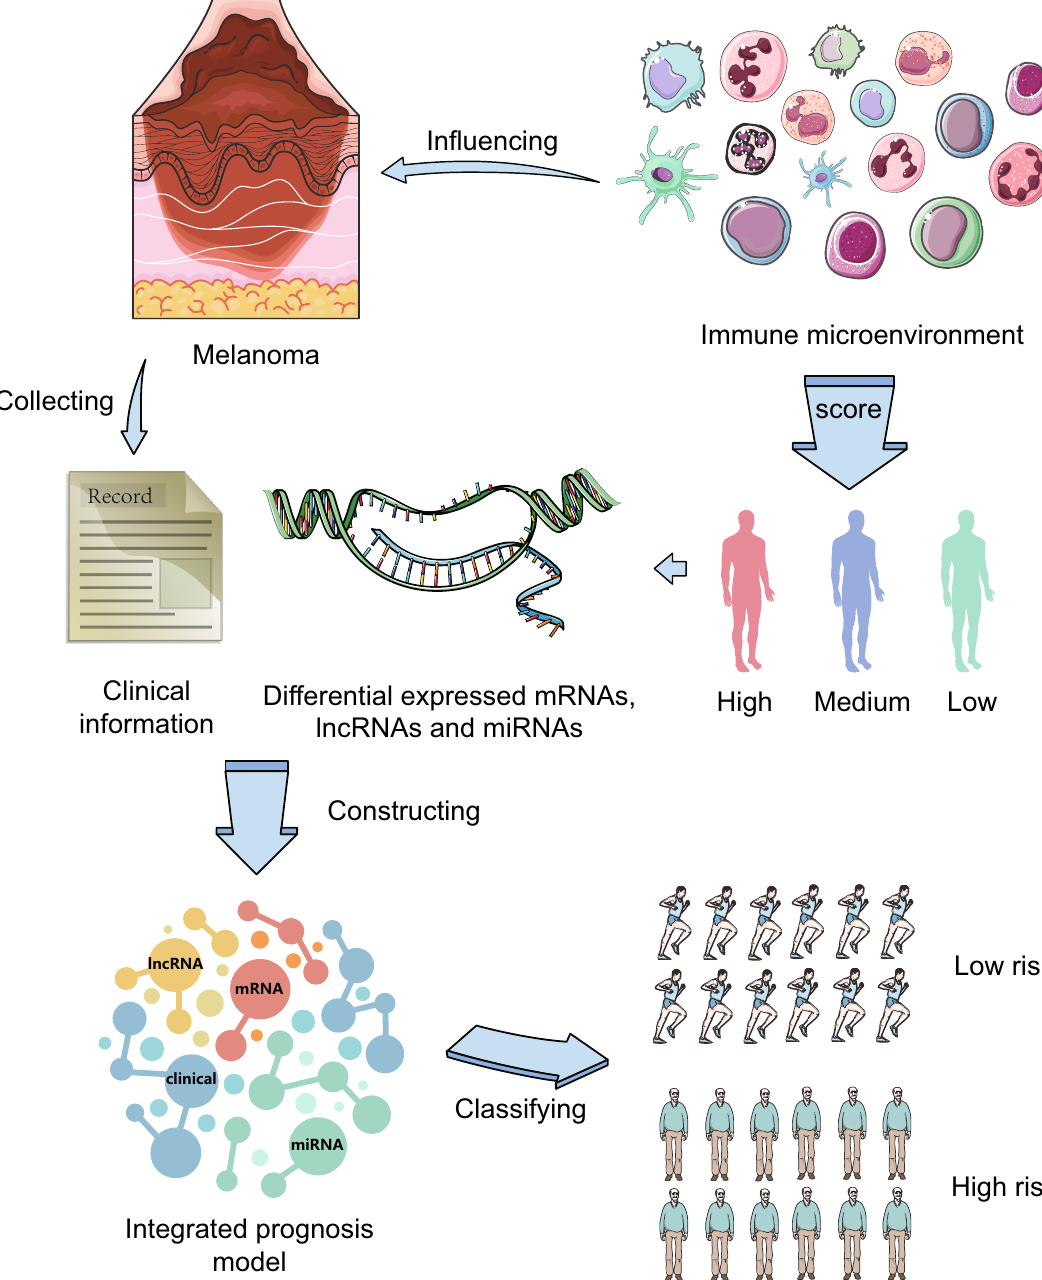
Figure 5. Graphical abstract. Tang et al. develop an immune-related method to predict the survival status of cutaneous melanoma patients. Comprehensive analysis of the nucleic acid and clinical information of the patients can obtain different prognostic groups. These factors may be the key to the treatment of cutaneous